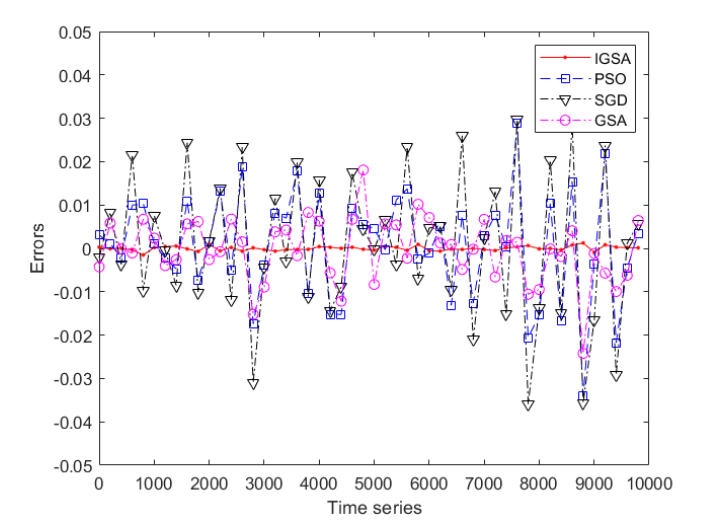
Figure 15. Predicted errors for the MG time